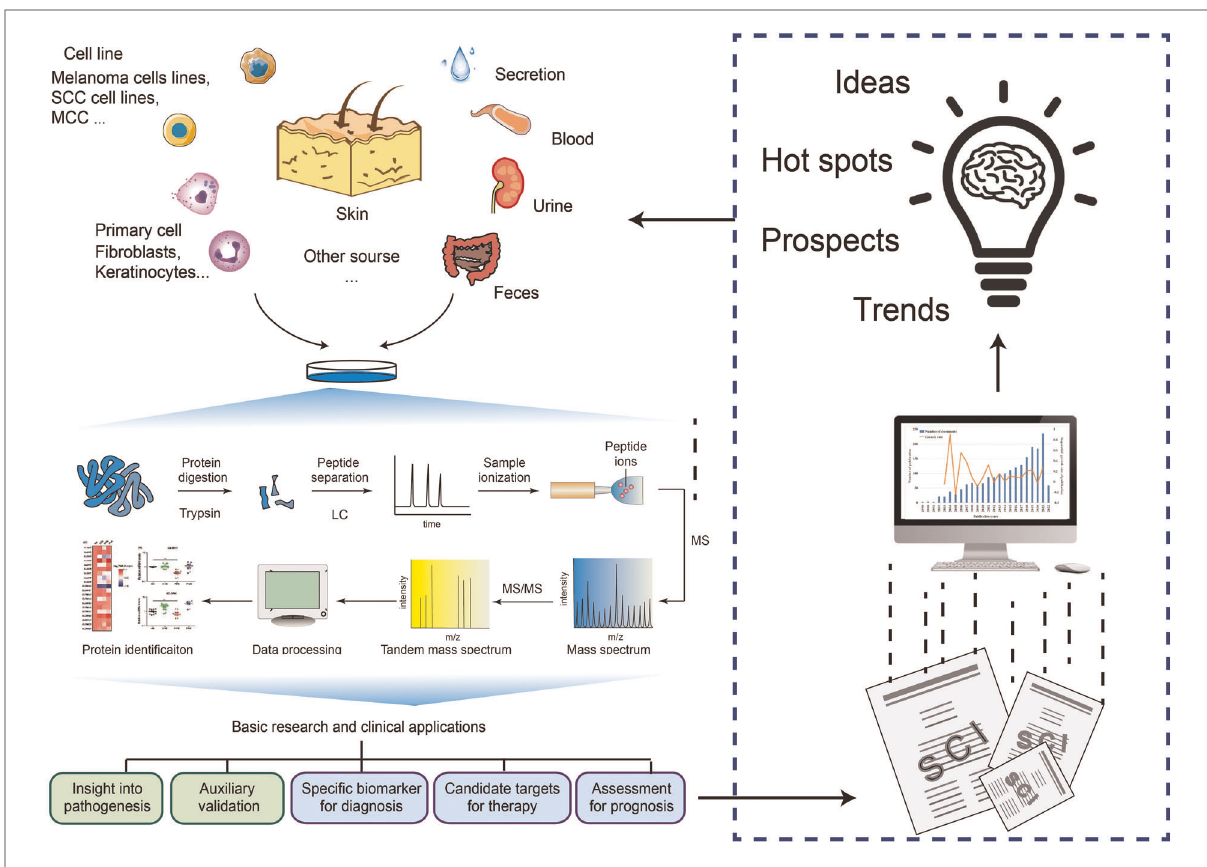
FIGURE 1 Bibliometric and data mining provide insights and trend analysis of proteomics in skin disorder. SCC, squamous cell carcinoma; MCC, Merkel cell carcinoma; LC, liquid chromatogram; MS, mass